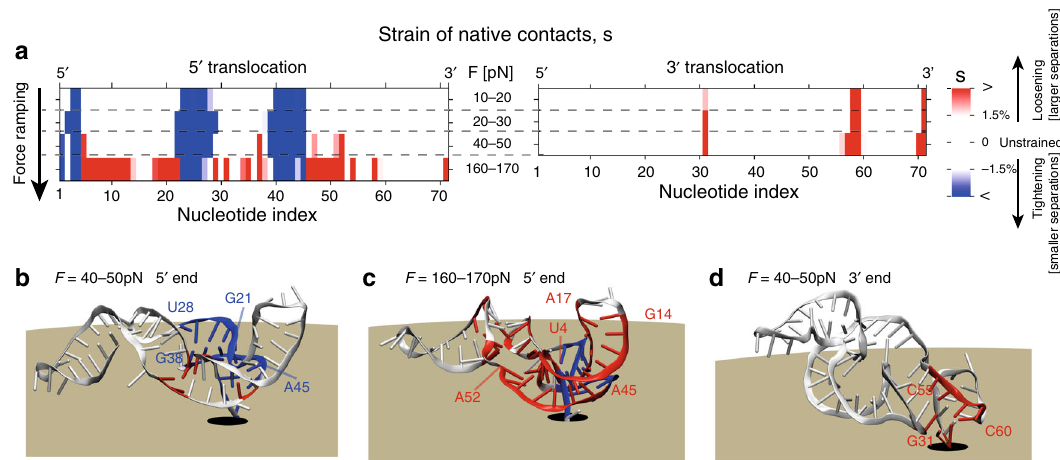
Fig. 4 Mechanics of Zika xrRNA directional resistance to translocation. a Kymograph of the strain of native interactions, s , during the loading stages of force-ramped translocation. Negative or positive value of the strain parameter indicate that natively-interacting atoms are, respectively, closer or further apart than in unstrained xrRNA, re fl ecting the local tightening or loosening of the structure. The nucleotide-wise pro fi le of the strain was computed for the indicated force ranges over 20 translocation trajectories at T = 300 K and r = r 0 , see “ Methods ” and Supplementary Fig. 6. Nucleotides whose native contact network is signi fi cant strained ( ∣ s ∣ > − 1.5%) are highlighted in b – d . The color code is the same as for a